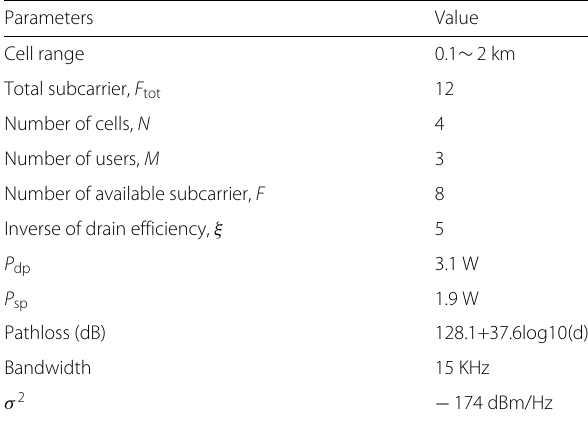
Table 2 Simulation